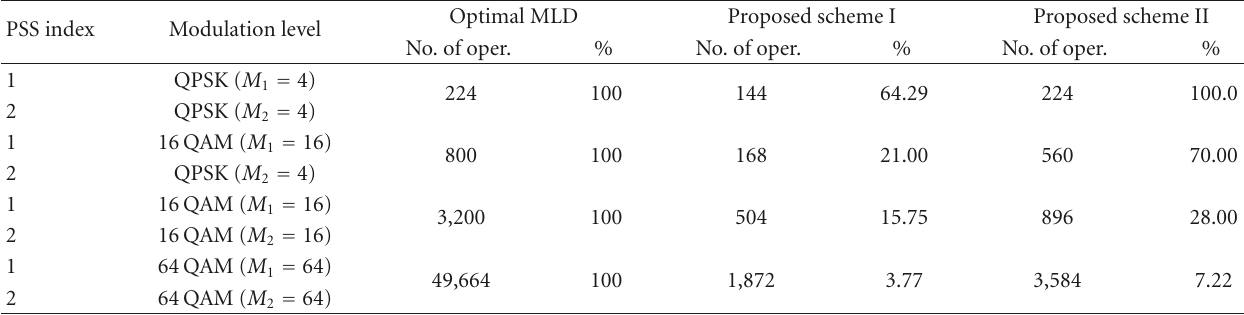
Table 4: Complexity comparison for real multiplication operations ( N t = N r = 2, per one subcarrier).